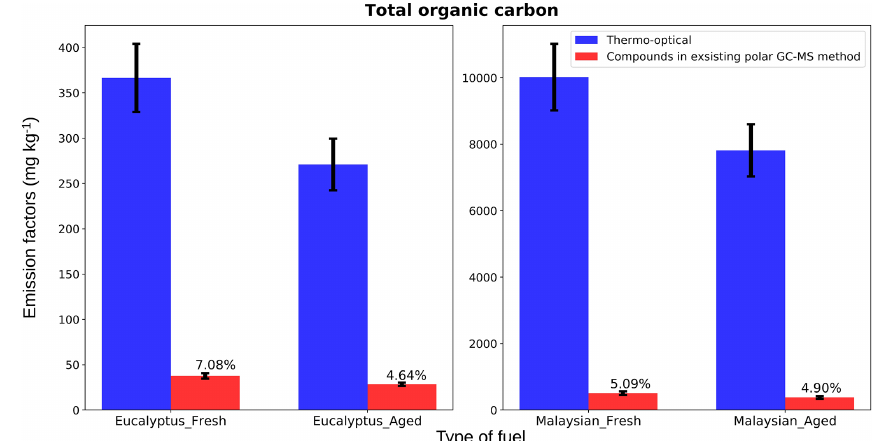
Figure 12. Contribution of GC-MS characterized polar compound carbon mass to total thermo-optical organic carbon mass. The y axis shows the total carbon mass with dimensions of mass per mass. The error bars represent the analytical uncertainties of the methods. For the thermo-optical method, uncertainties are the standard deviation of results from multiple punches on the same filter, and for the GC- MS method, uncertainties were computed by taking the square root of the sum of the squares of individual analytical uncertainties of all compounds